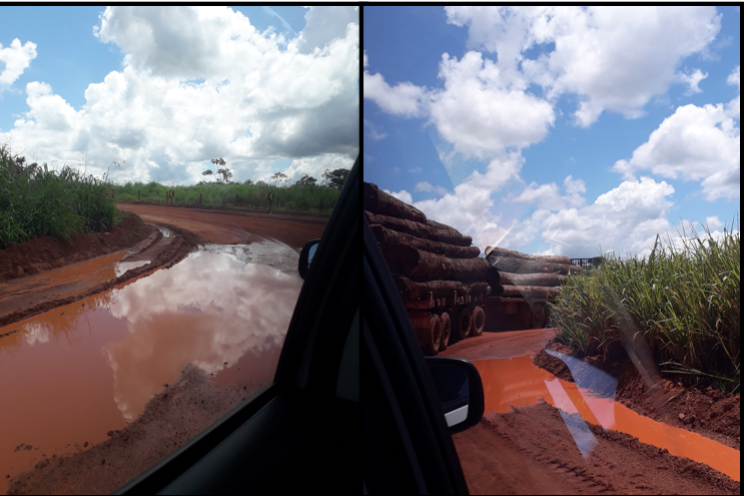
Figure 1. Poor road conditions in the Aripunã